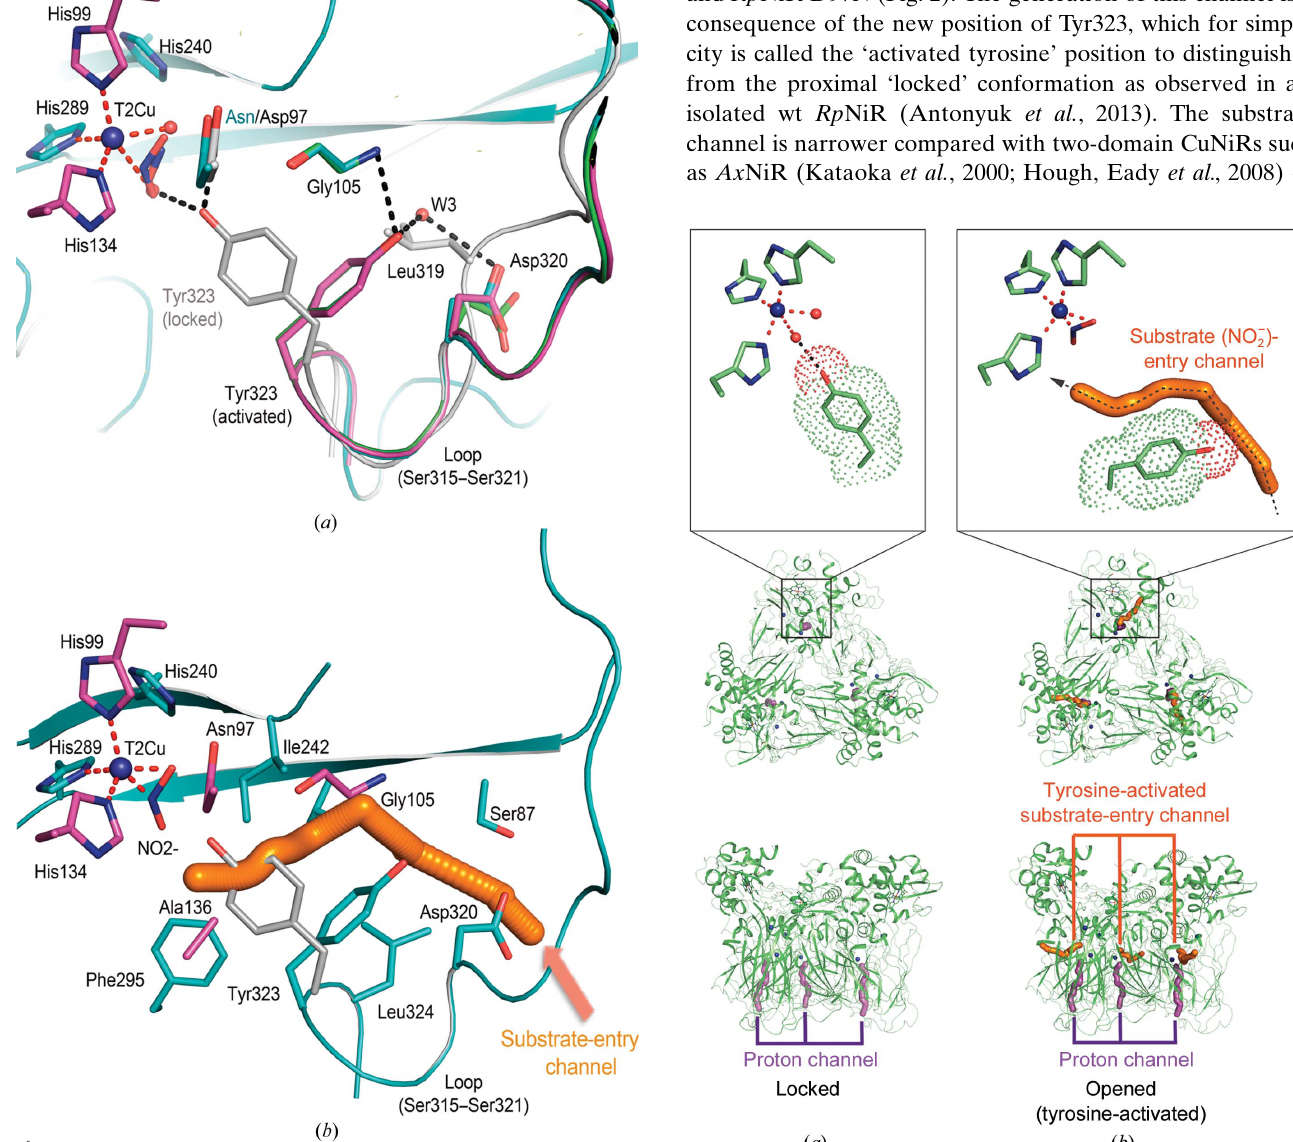
Figure 2 Details of the structural rearrangement accompanying the Tyr323 flip. (cid:2) (magenta) structures show a similar conformation of Tyr323 2 and loop (Ser315–Ser321) which differs from the free oxidized resting- state wt Rp NiR (grey). ( b ) The narrow putative NO-release channel opened by the conformational change, with resting-state Tyr323 shown in grey. T2Cu coordination bonds are coloured red. Water molecules are shown as red